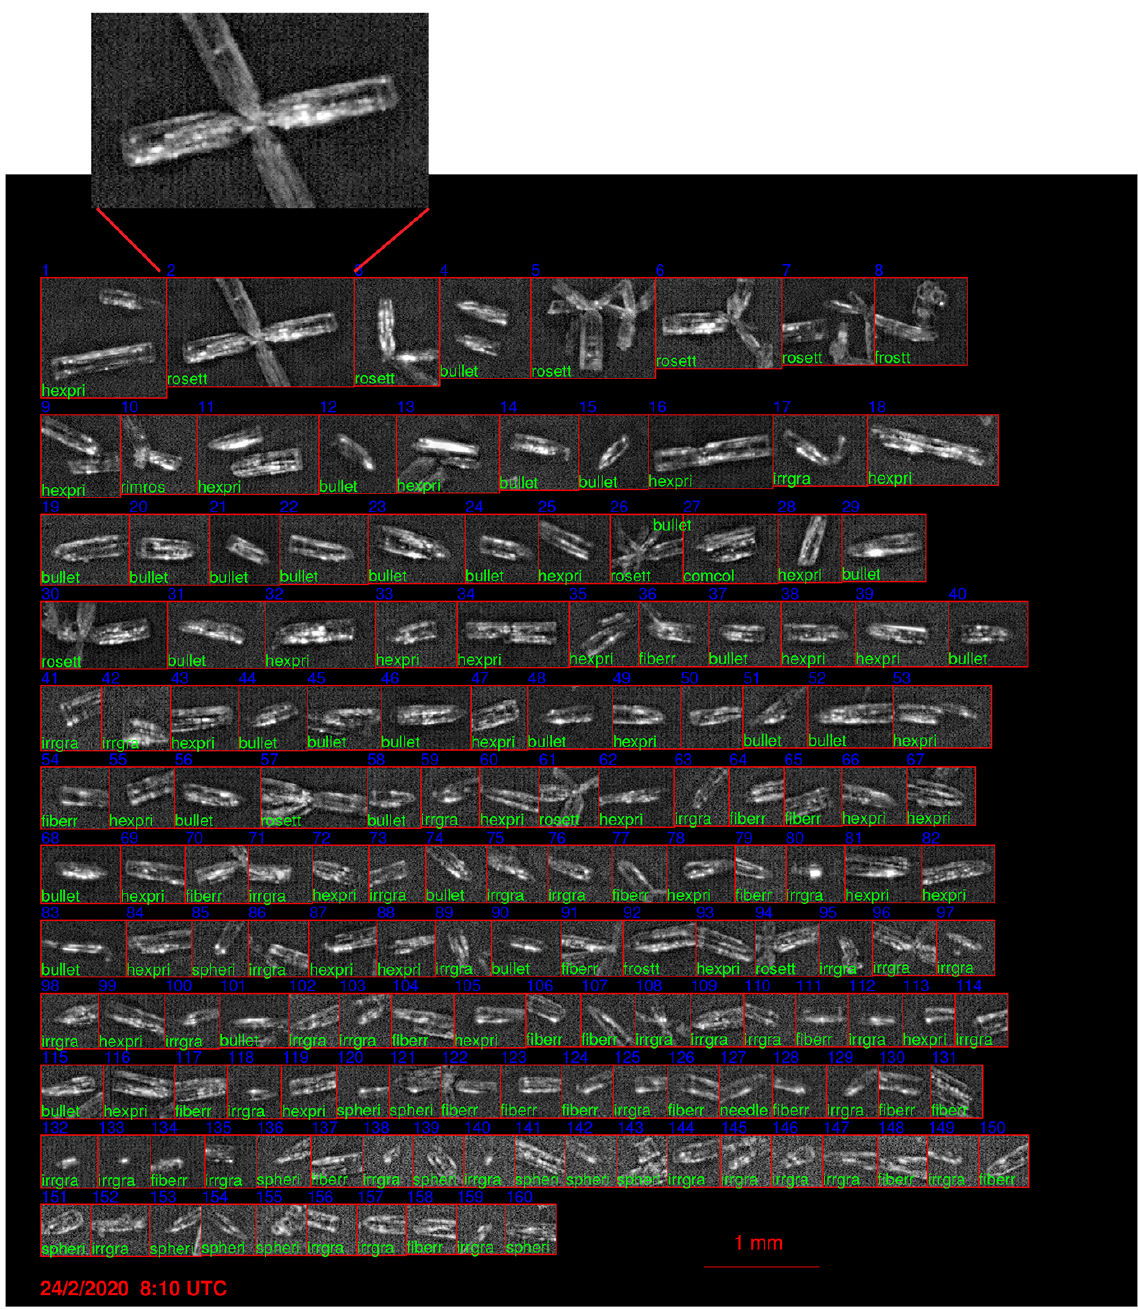
Figure 20. As Fig. 19, but for the day of 24 February 2020 at 08:10UTC. The photograph indicates a large amount of hexagonal columns with a small amount of bullet rosettes also present. In the upper part is the zoom of a single bullet rosette crystal.